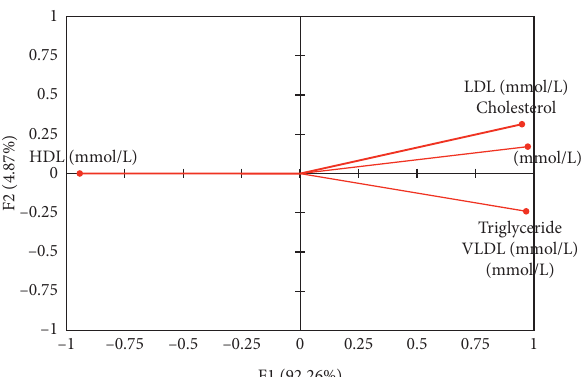
Figure 4: Correlation plot of lipid profile parameters on male albino rats against the generated factors (F1 and F2). Variables (axes F1 and F2: 97.13%).